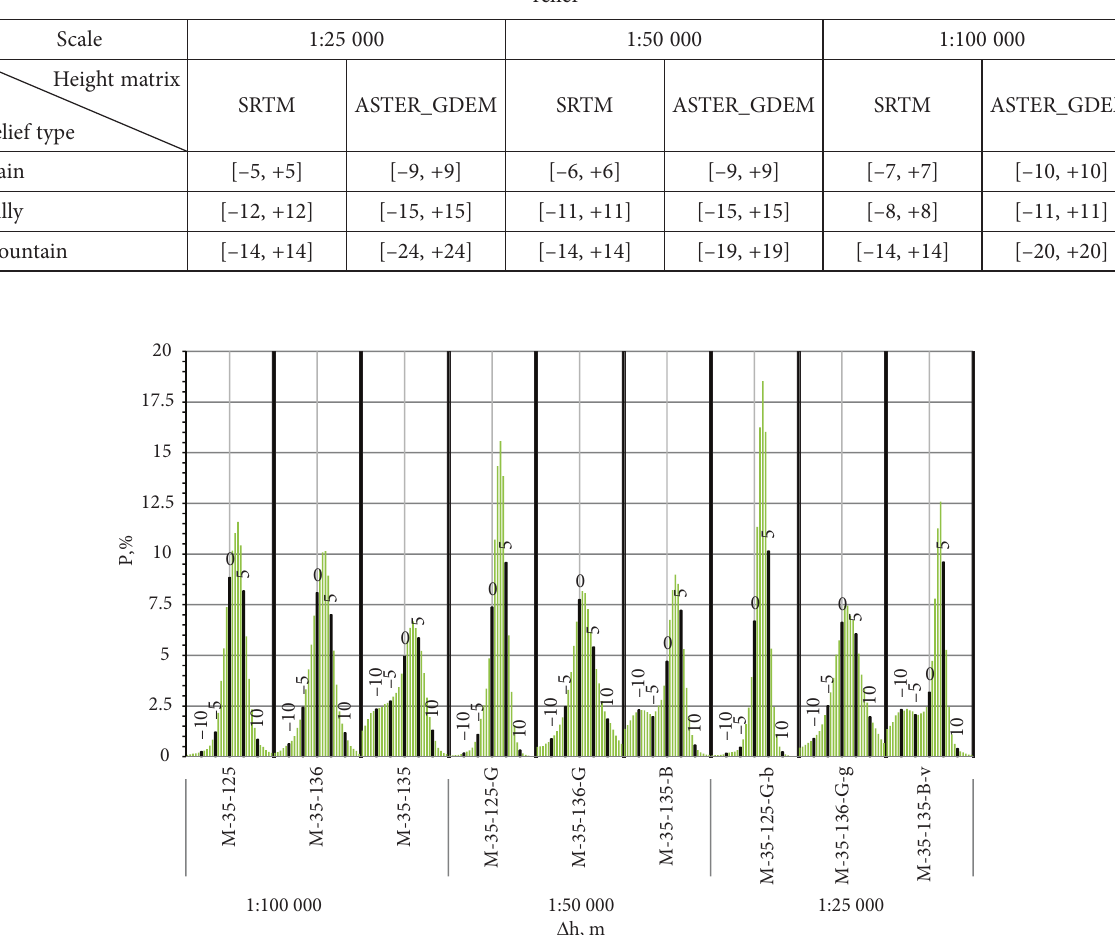
Fig. 5. SRTM Elevation Error Distribution Histogram for different scales and terrain conditions